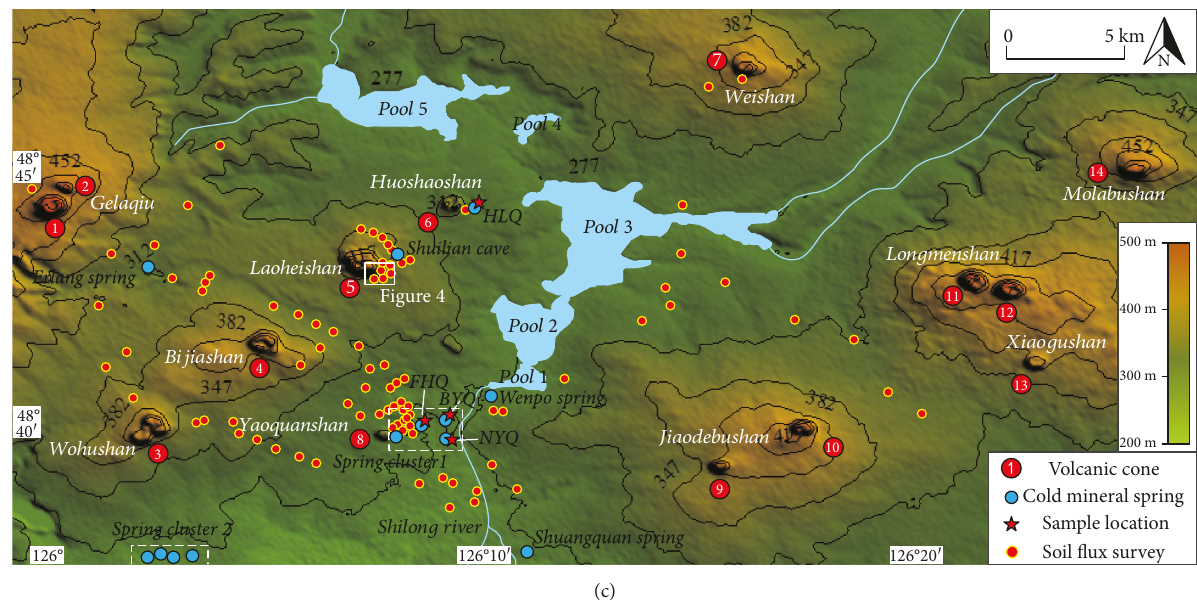
Soil flux survey 126 ° 20 ′ 126 ° 10 ′ 126 ° Figure 1: (a) Geological and tectonic map showing the locations of major faults and Cenozoic basaltic volcanic fi elds in NE China (modi fi ed from Liu et al. [10]). The inset shows the location of Eastern China. Abbreviations of Cenozoic volcanic fi elds in NE China are as follows: WMVF: Wudalianchi monogenetic volcanic fi eld; XK: Xunke; KL: Keluo; NMH: Nuominhe; XGLH: Xiaogulihe; AES: Aershan; JPH: Jingpohu; LG: Longgang; CBS: Changbaishan; KD: Kuandian; SLB: Songliao basin; NCC: North China craton. (b) Geological map of WMVF (modi fi ed from Zhao et al. [23]). (c) Geomorphologic map showing the location of monogenetic volcanoes and cold springs in fl ux survey, and the stars represent the sample WMVF. Red dots represent the location of the soil CO 2